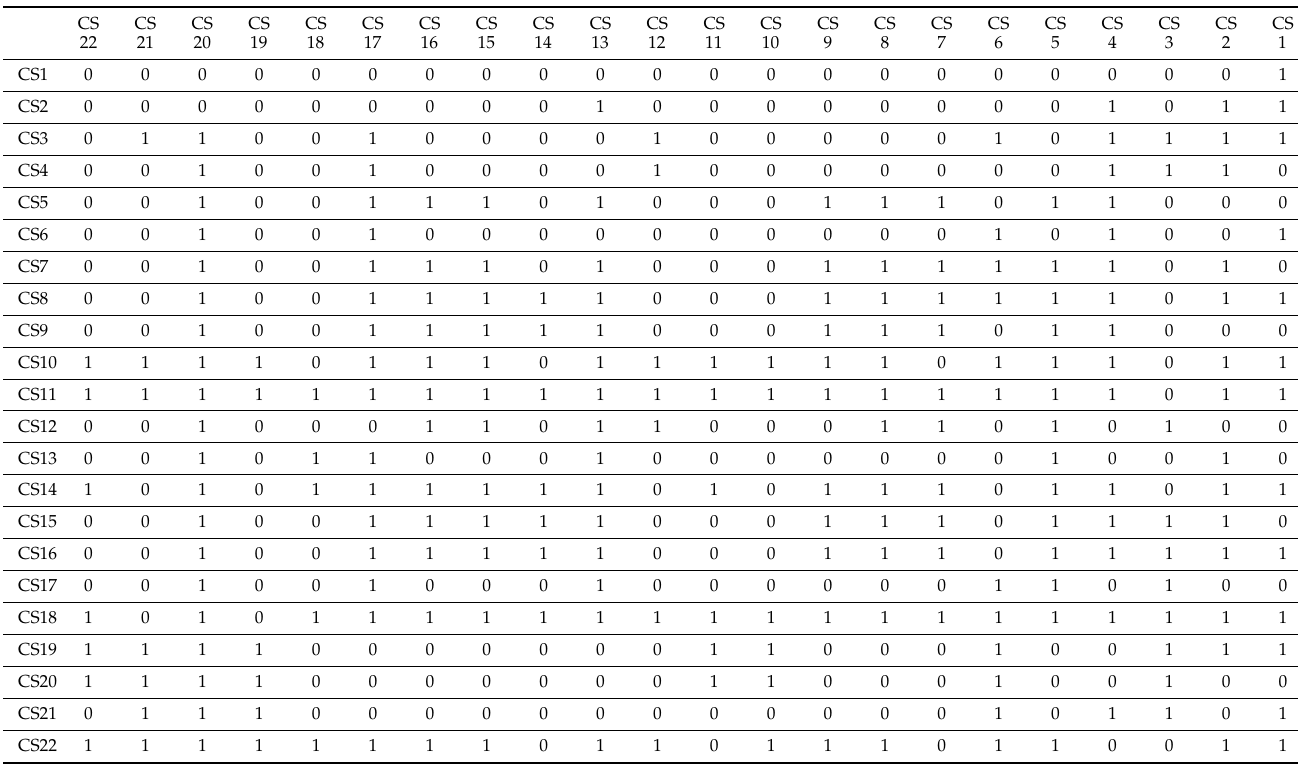
Table A3. Final reachability matrix.